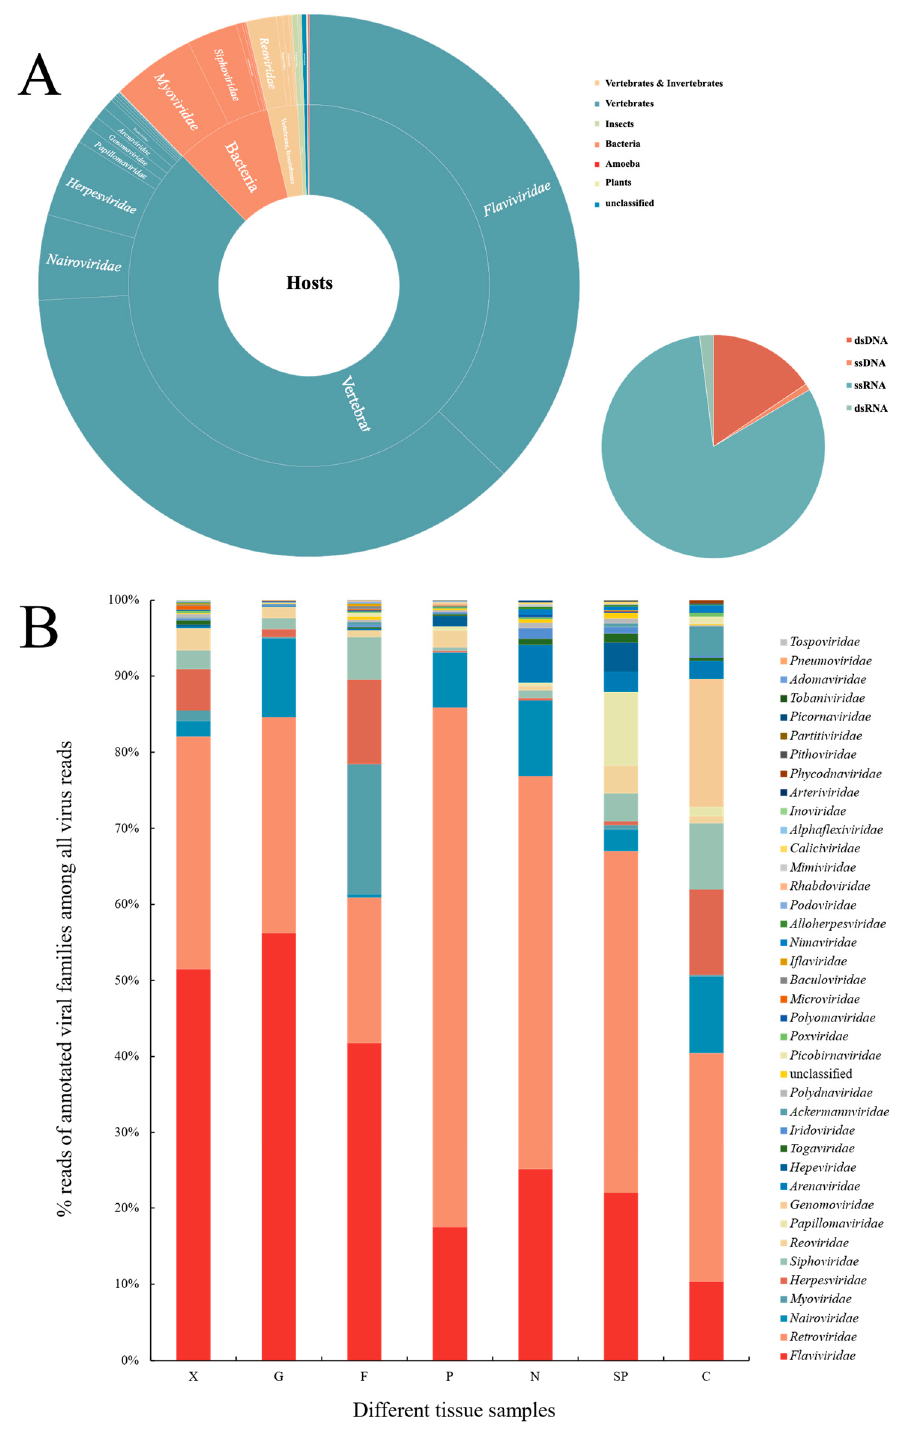
Figure 2. ( A ) Overview of the viral reads. The numbers of viral reads from each sample are described in Additional file Table S1. ( B ) The percentage of reads that are related to the most abundant viral families among all the virus reads, indicated in the same colors for each main viral category. virus families are indicated by the color code on the right.